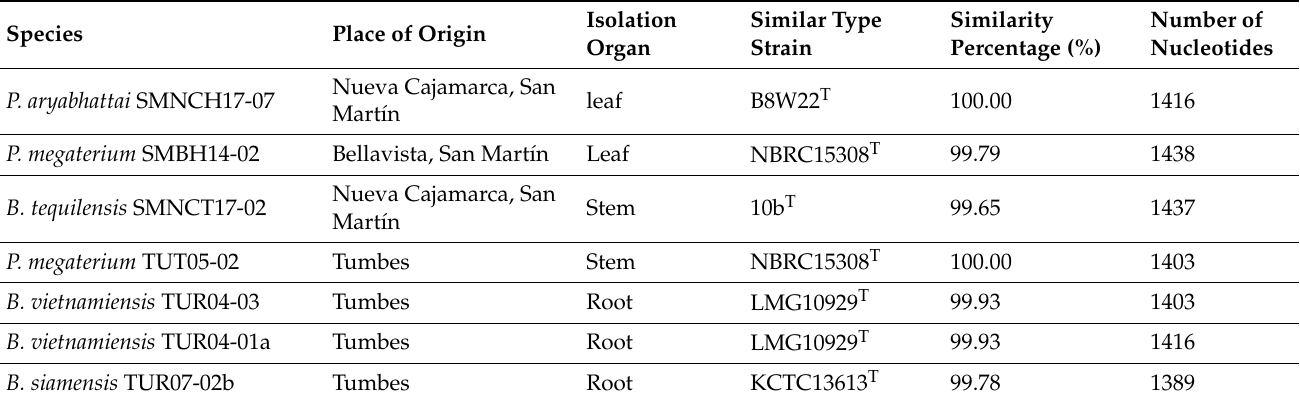
Table 6. Origin and taxonomic affiliation using the 16S rRNA gene of endophytic rice strains, adapted from